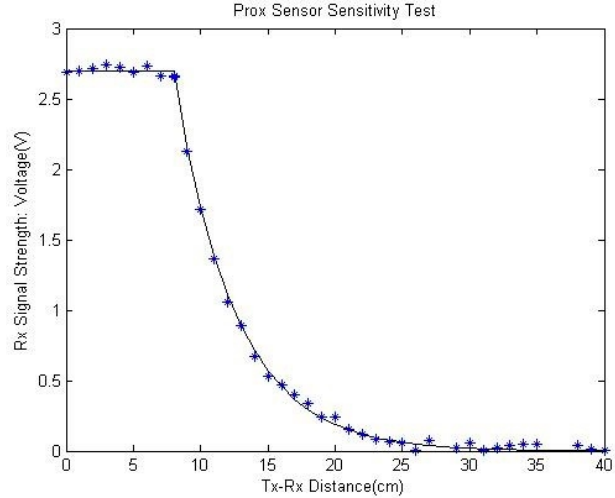
Figure 16. Proximity sensor sensitivity test. (Tx: Transmitter, Rx: Receiver, Prox: Proximity)